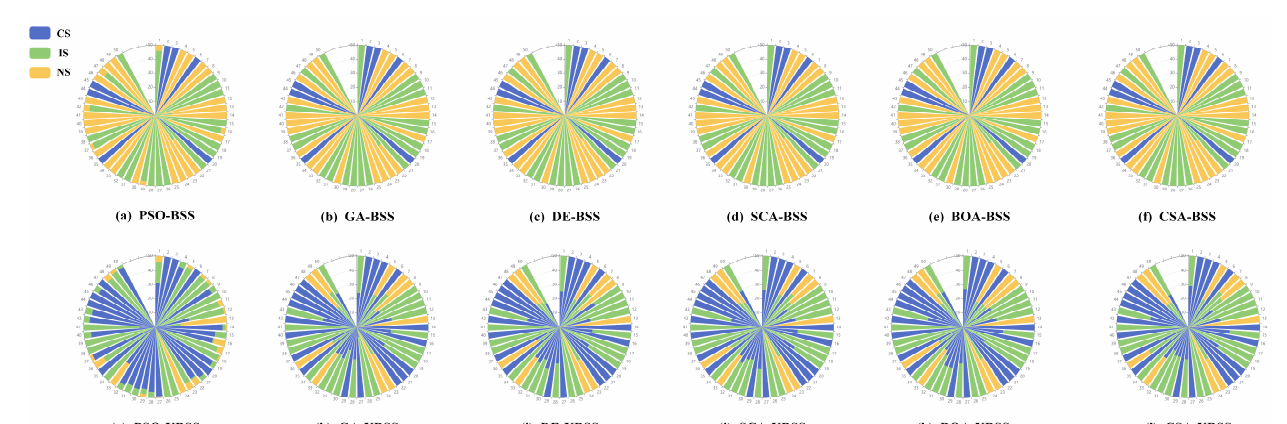
Figure 6. Separation results of 50 groups of mixed signals: ( a – f ) the SI-BSS based on PSO, GA, DE, SCA, BOA, and CSA. ( g – l ) the SI-XBSS of PSO, GA, DE, SCA, BOA, and CSA. The success rate of separation, defined as Equation (9), of the SI-XBSS with six opti- mization algorithms, is shown in Figure 7. The separation success rate of SI-XBSS ex- ceeded 35% of that of SI-BSS, among which the PSO-XBSS improved 43.32%, which was the most significant improvement.